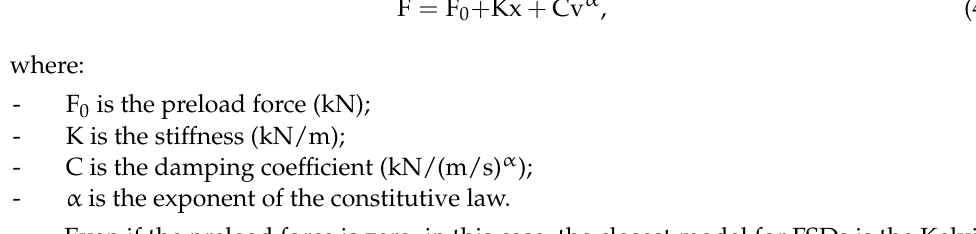
Figure 5. Normalized force vs. normalized velocity.